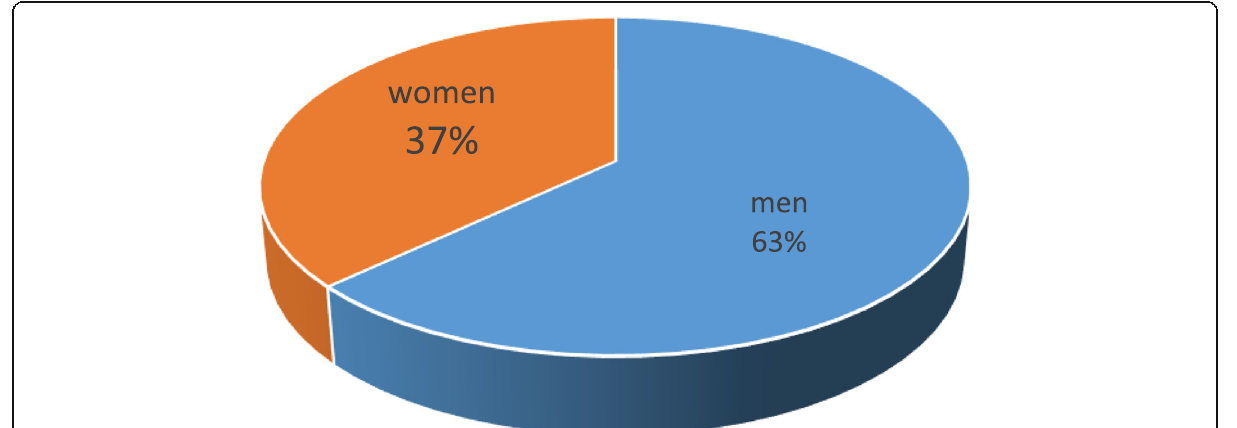
Fig. 2 The distribution of respondents by gender. Source “ by the author ”